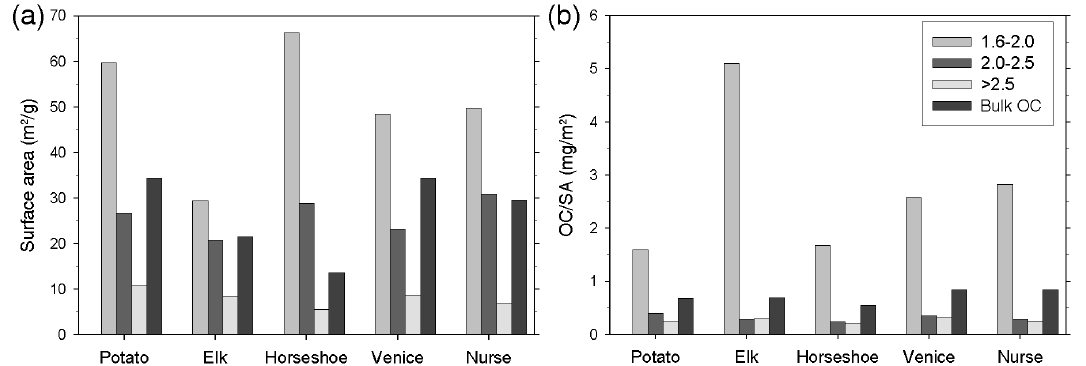
Figure 4. Surface area (SA) (following combustion) (a) and organic carbon/surface area ratio (OC/SA) (b) for Delta bulk sediment and density